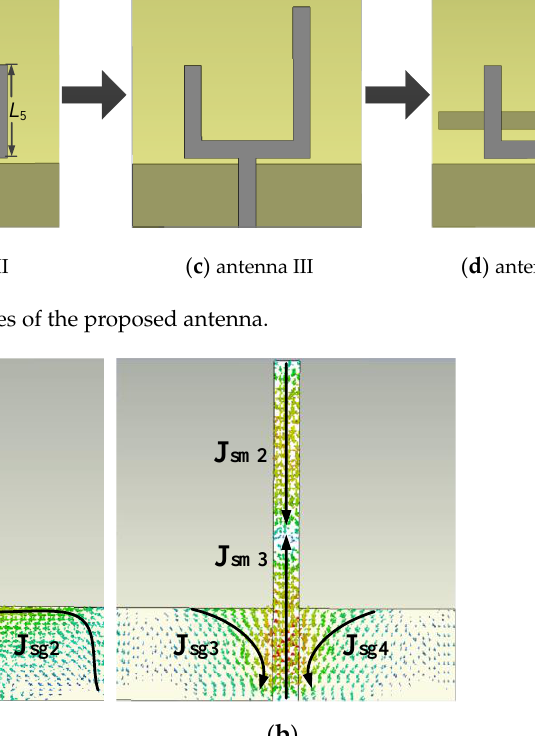
Figure 3. Surface current of the proposed monopole (Ant. I): ( a ) low-order mode; ( b ) high-order mode.